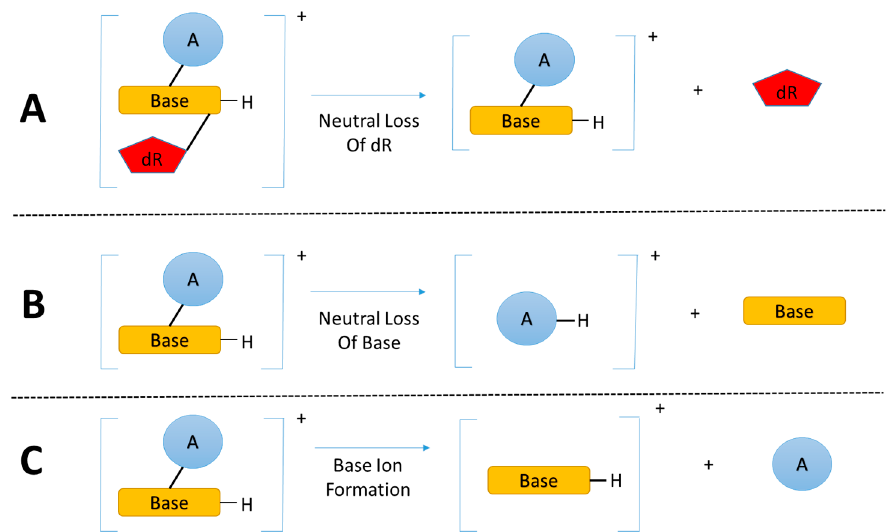
Figure 2. ( A ) The dominant fragmentation pathway of nucleoside adducts is the neutral loss of the 2’- deoxyribose moiety; ( B ) and ( C ) Common fragmentation pathways of nucleobase adducts. (Base = nucleobase, A = modification, and dR =